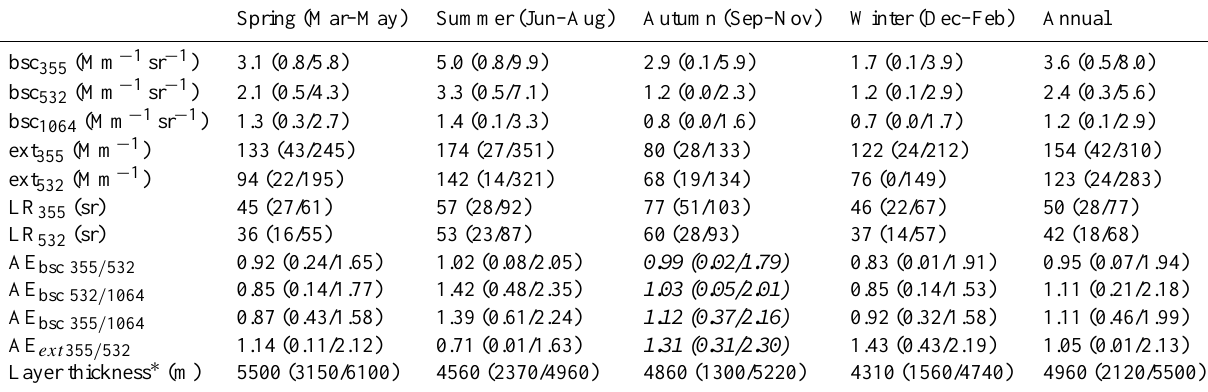
Table 2. Summary of the seasonal particle properties at Gual Pahari. Given values for backscatter, extinction, lidar ratio and ˚Angstr¨om exponents are mean values of the season at 1–3km altitude and 10 and 90 percentiles at the same height.